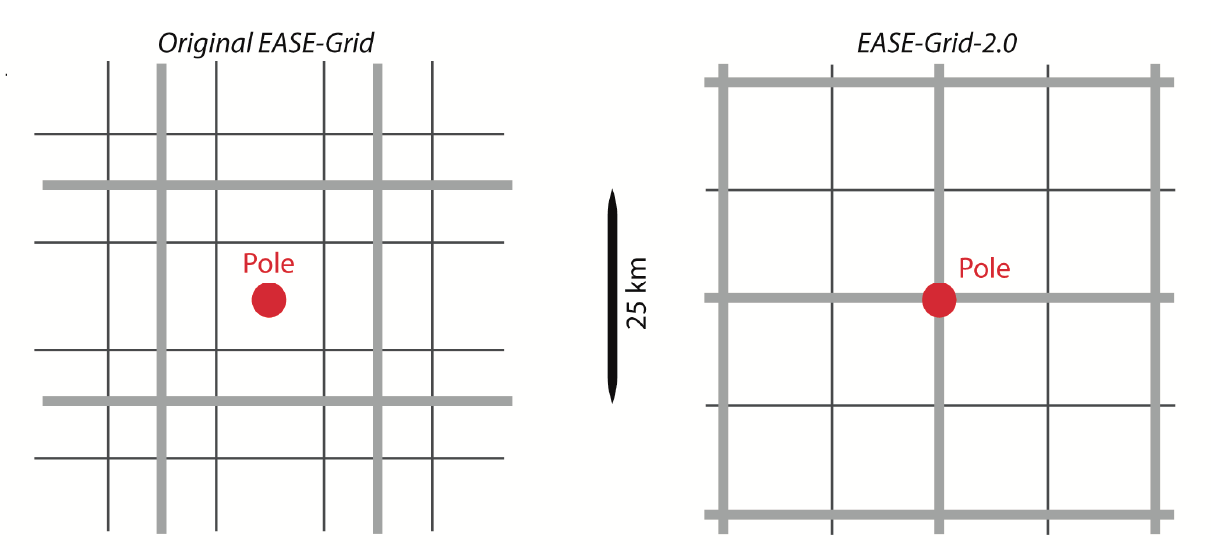
Figure 5. Relative gridding schemes for representative azimuthal 25 km and 12.5 km original EASE-Grid (( Left ), bore-centered) vs . EASE-Grid 2.0 (( Right ), nested) cells near the